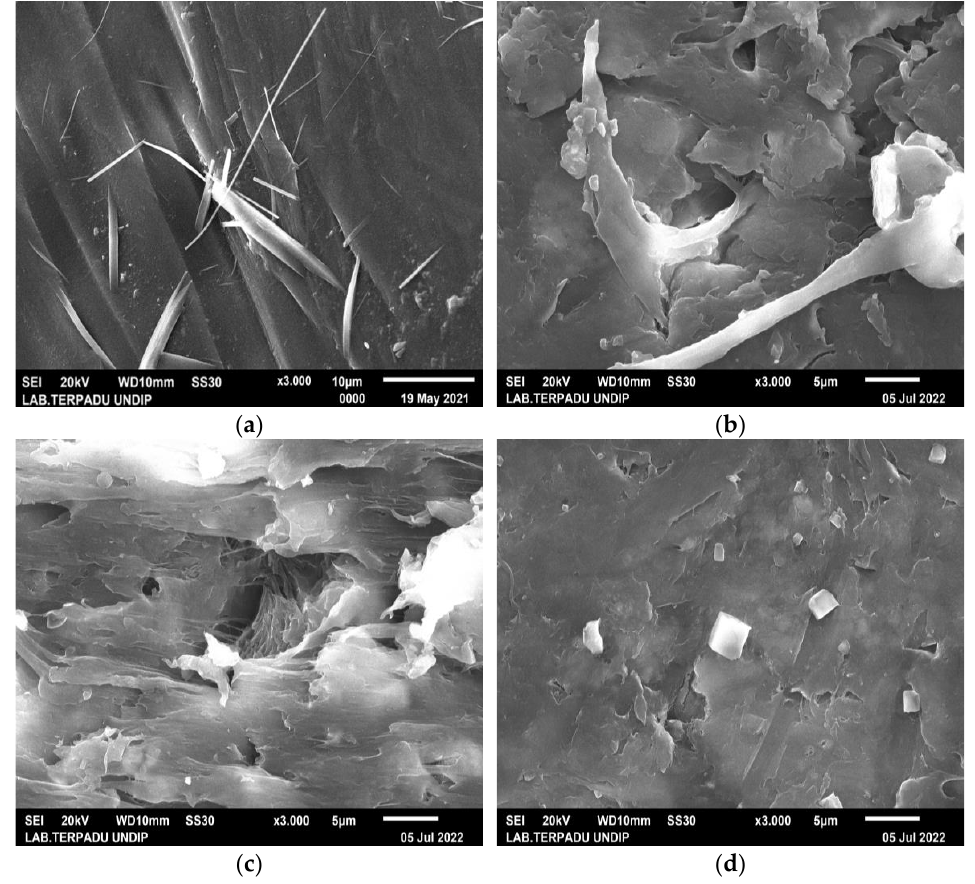
Figure 3. SEM images of PLA/PCL/nHA biocomposite specimens of ( a ) 0%; ( b ) 10%; ( c ) 20%; and ( d ) 30%, at 3000× magnification.